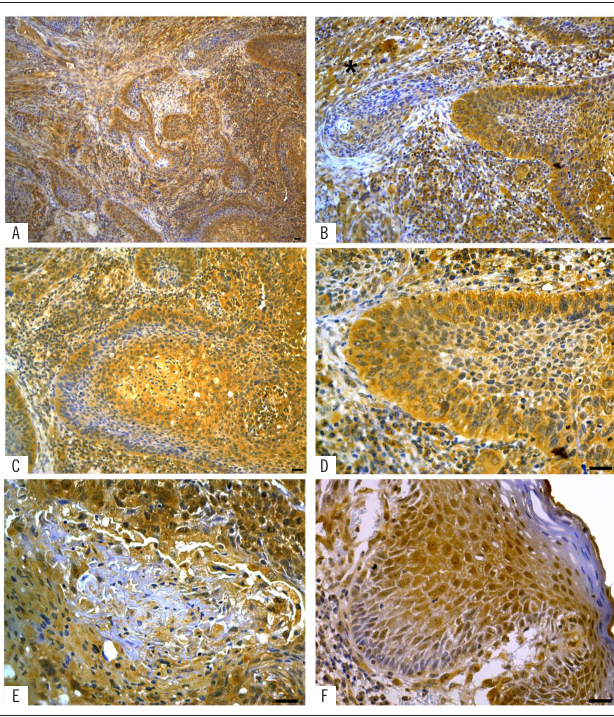
FIGURE 3 – Immunolabeling photomicrographs for TIMP-1 in stage II SCC Figura 3: Fotomicrografias de imunomarcação de TIMP-1 em CCE Grau II. (A) Imagem panorâmica mostrando áreas invasivas e perda da arquitetura do epitélio. Marcação A) panoramic image showing invasive areas and loss of epithelial architecture. Labeling presente no parênquima e no estroma e de forma heterogênea. (B) Fibroblastos present in the parenchyma and stroma heterogeneously; B) fibroblasts expressing TIMP-1 expressando TIMP-1 (*) e camada epitelial basal hiperplásica com intensa marcação. ( * ) and hyperplastic basal epithelial layer with intense labeling; C and D) detail of the (C e D) Detalhe do epitélio mostrando variação na expressão da molécula entre os epithelium showing variation in the molecule expression among strata, strong labeled estratos, queratinócitos da camada basal e da camada espinhosa bem marcados e as keratinocytes of the basal layer and spinous layer, and cells of the parabasal layer not células da camada parabasal não marcadas. (E) Ilha tumoral com variação na labeled; E) tumor island with variation in TIMP-1 expression, most of the cells are poorly expressão de TIMP-1, sendo que a maior parte das células estão pouco diferenciadas differentiated and weakly labeled; F) area of the lesion in which the epithelium structure is e pouco marcadas. (F) Área da lesão em que a estrutura do epitélio está mantida, preserved, presence of strong labeled cells in the spinous layer, while the keratinocytes in the presença de células da camada espinhosa bem marcadas, enquanto que basal layer and with loss of polarity are weakly labeled; scale bar = 20 µm. queratinócitos da camada basal e com perda de polaridade estão fracamente TIMP-1: tissue inhibitor of metalloproteinase-1; SCC: squamous cell carcinoma. marcados. Barra de escala = 20  m.